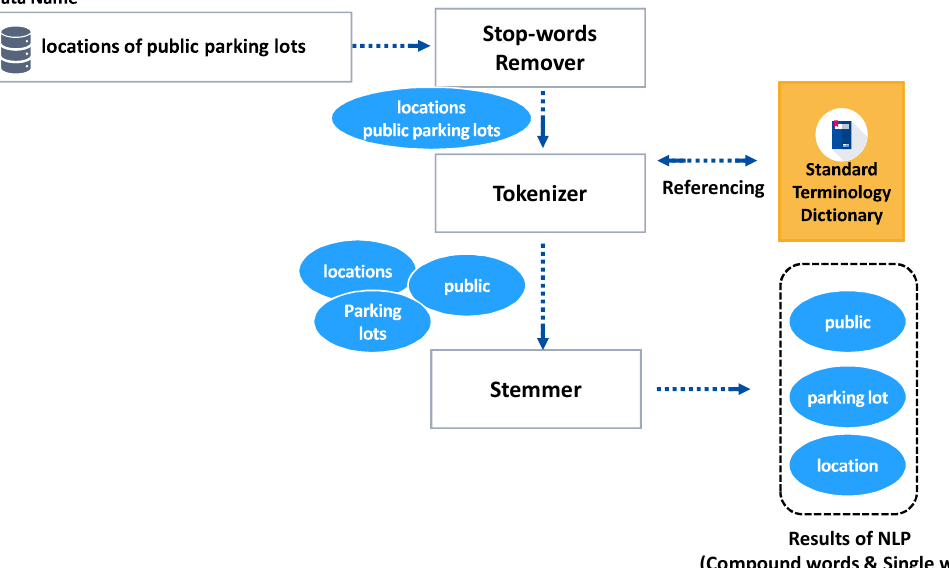
Figure 5. An Example of Natural Language